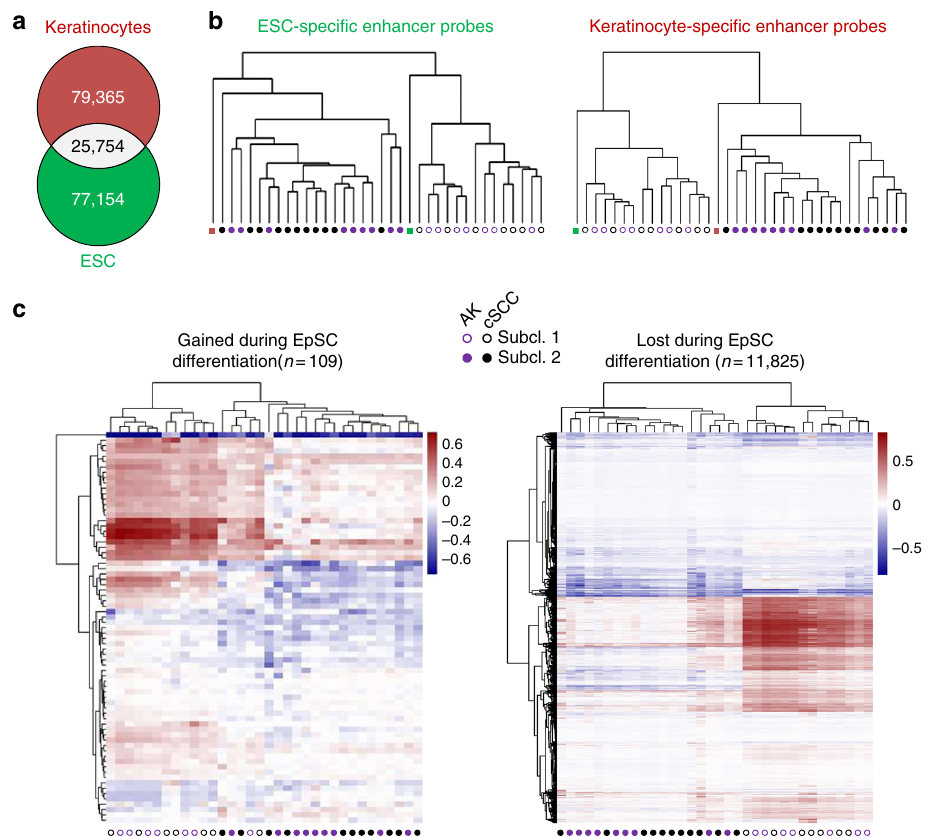
Fig. 6 Enhancer methylation patterns separate AK and cSCC into keratinocyte-like and epidermal stem cell-like subtypes. a Venn diagram displaying the total number of enhancer regions de fi ned for human embryonic stem cells and keratinocytes, respectively 47, 48 . As expected, both cell types only share about a quarter of their enhancers ( b ) Hierarchical clustering of AK and cSCC epidermis samples based on the methylation status of the 850k probes contained in ESC (left) and keratinocyte (right) enhancers. Methylation pro fi les of ESCs epidermis samples were used as reference. Filled and empty circles denote the two distinct subclasses of AK (purple) and cSCC (black), respectively. c Heatmaps showing the methylation pro fi les of enhancers gained ( n = 109, left) and lost ( n = 11,825, right) during EpSC differentiation, in AK and cSCC epidermis samples, respectively. Colors represent the normalized average methylation levels of each enhancer